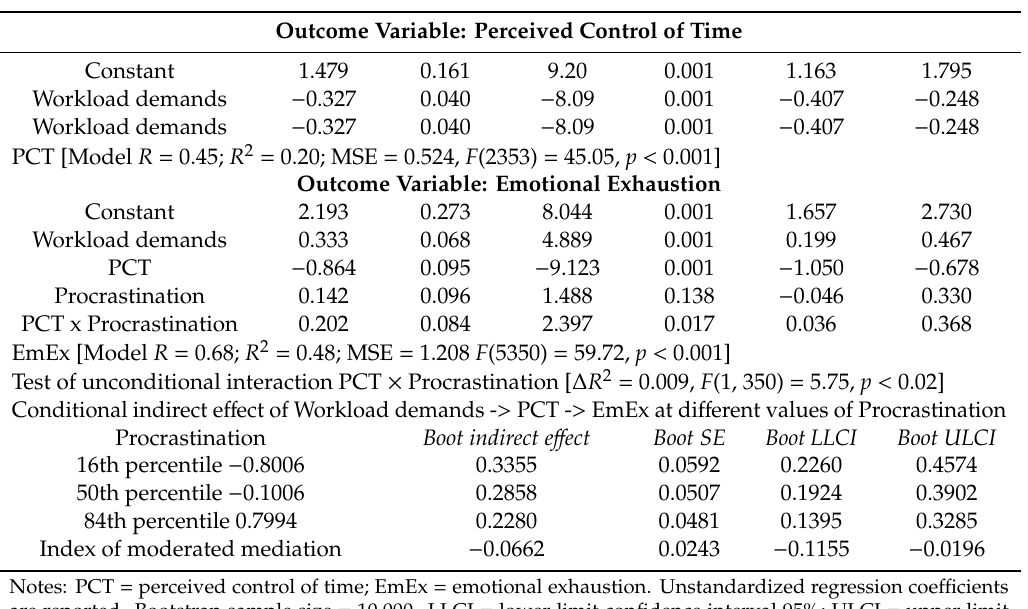
Table 2. Ordinary least squares regression results for direct, indirect, and conditional e ff ects.